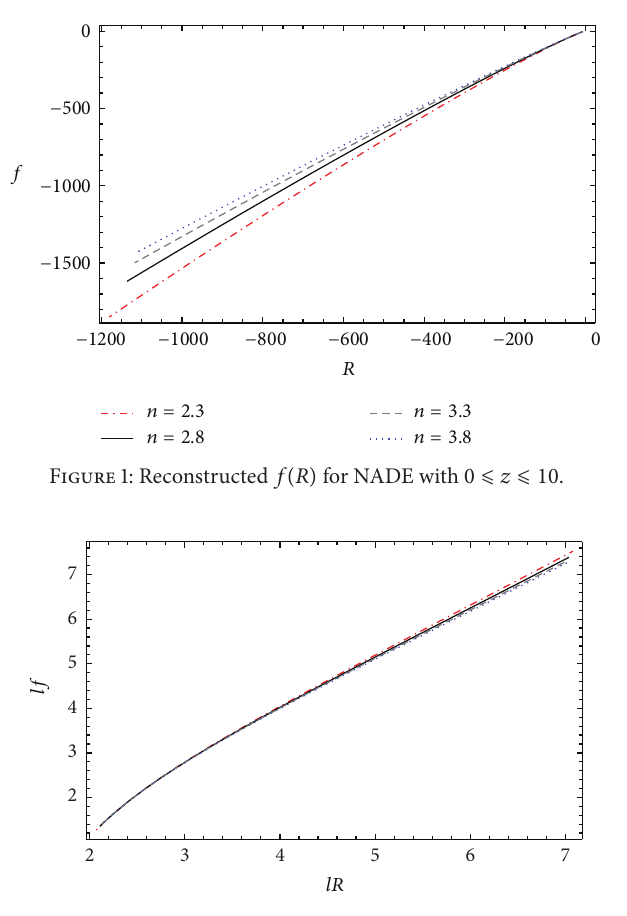
Figure 4: Future evolution of 𝑓(𝑅) for 𝑛 = 2.8 with −1 ≲ 𝑧 ⩽ 2